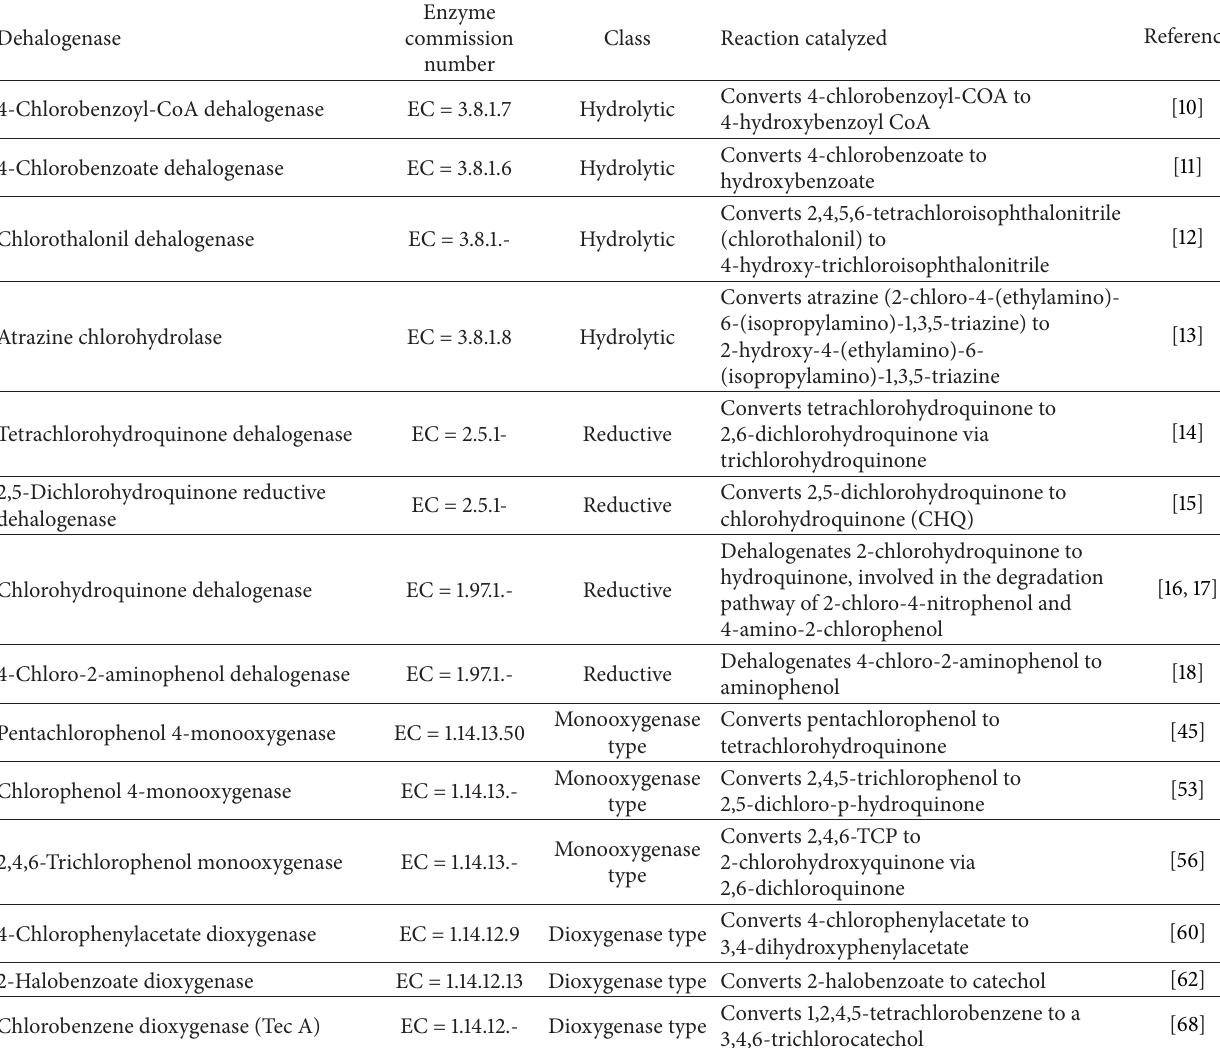
Table 1: A list of various dehalogenases involved in the aerobic biodegradation of chlorinated aromatic compounds.